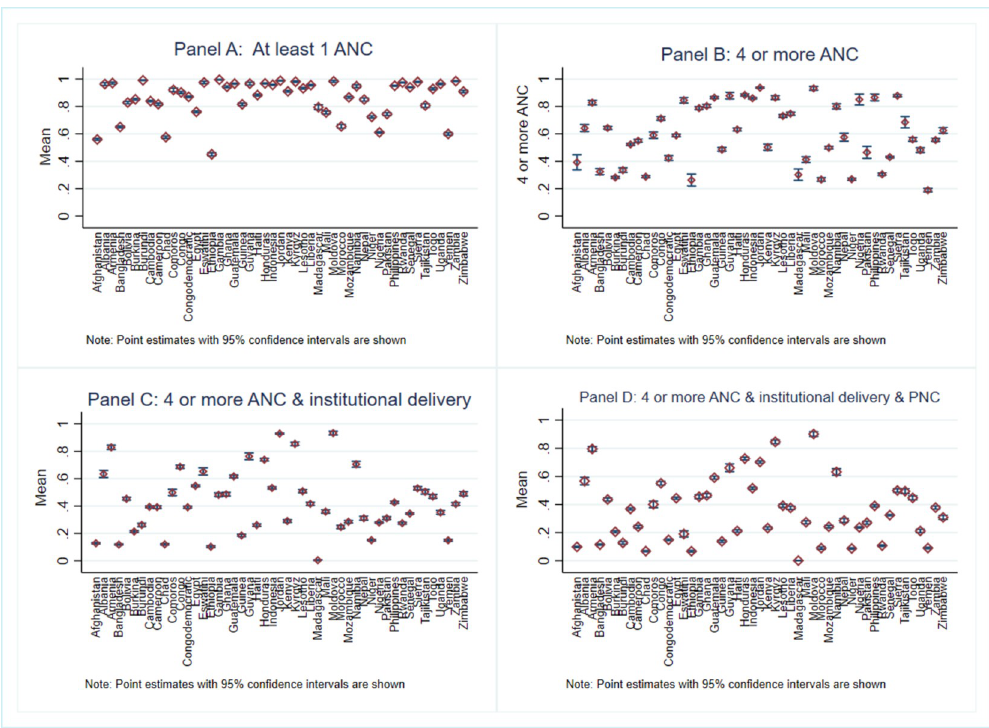
Fig 3. Levels of different components of CoC in maternal healthcare by countries. ANC, antenatal care; CoC, continuum of care; PNC, postnatal care.